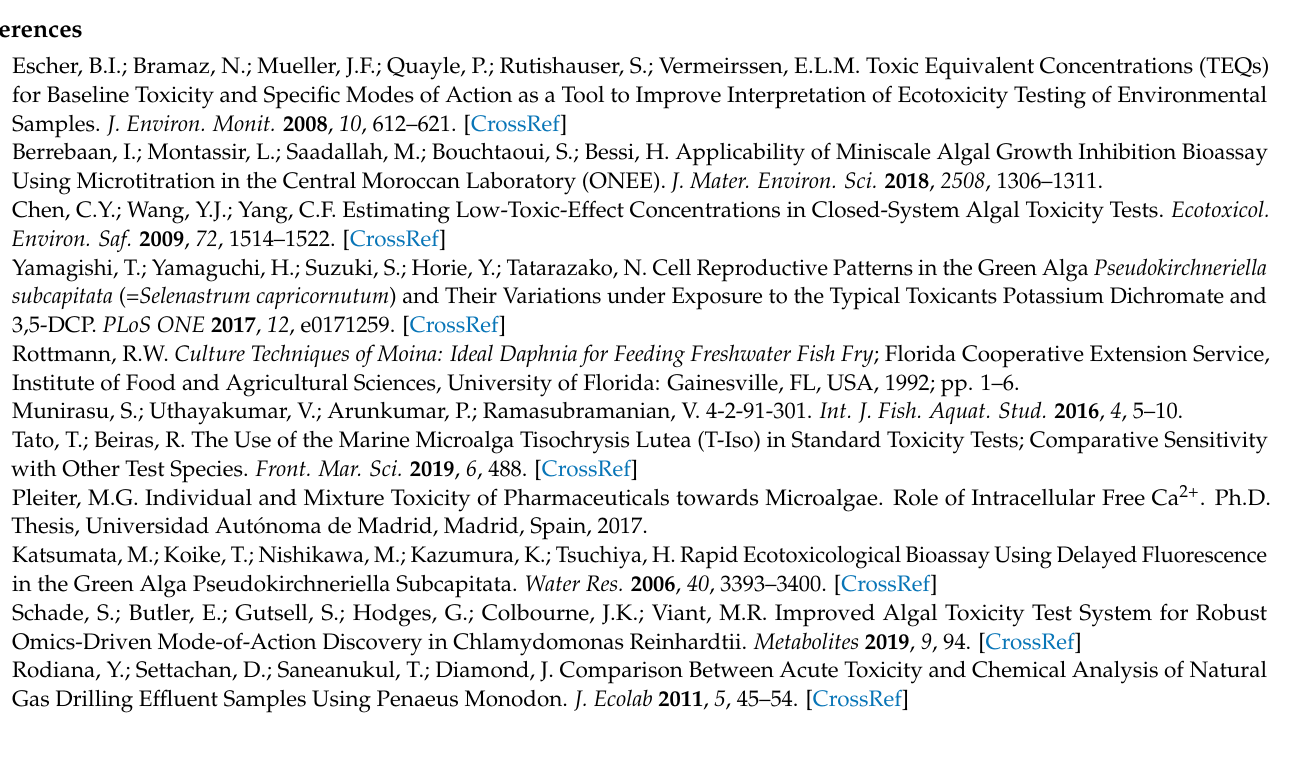
Table S5: Kinetic parameters for photocatalytic decontamination of Spiromesifen in Alga and Daphnia under direct sunlight using Fe2O3-Ag2O-TiO2 nanocomposites; Table S6: Kinetic parameters for photocatalytic decontamination of Spiromesifen in Alga and Daphnia under direct sunlight